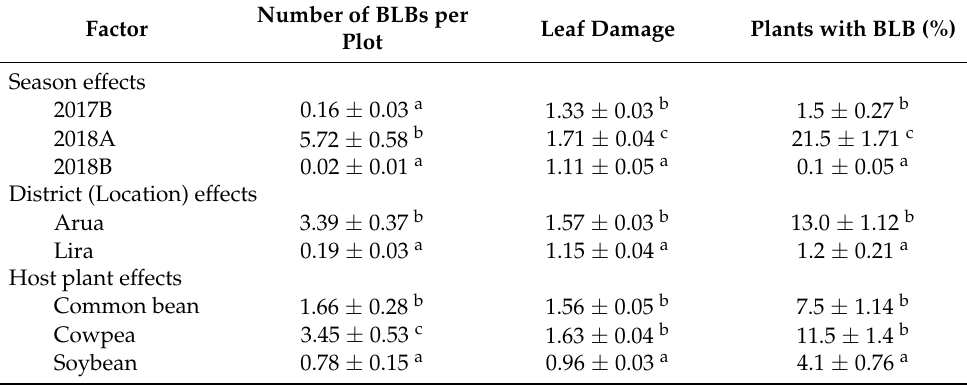
Table 1. Abundance of adult Ootheca spp. (mean ± s.e), leaf damage and incidence across seasons, districts, and host plants. Number of BLBs per Factor Leaf Damage Plants with BLB Plot